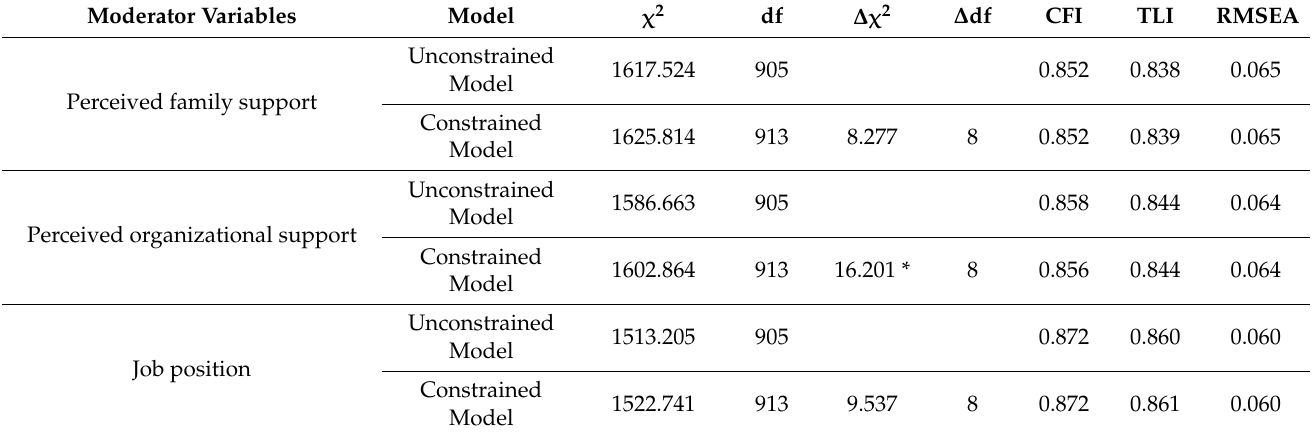
Table 9. Moderating effects analysis